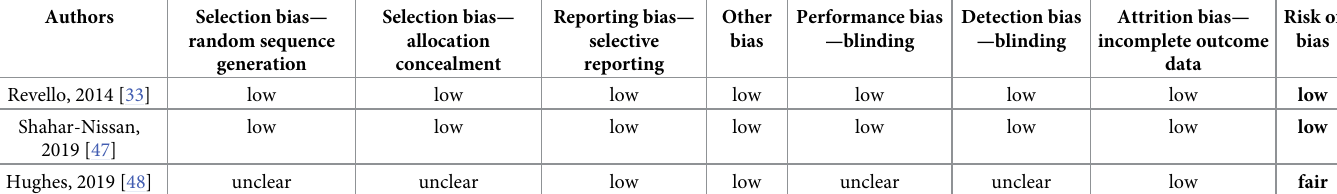
Table 3. Evaluation of risk of bias for randomized controlled trials (RCT) with Cochrane RoB tool.